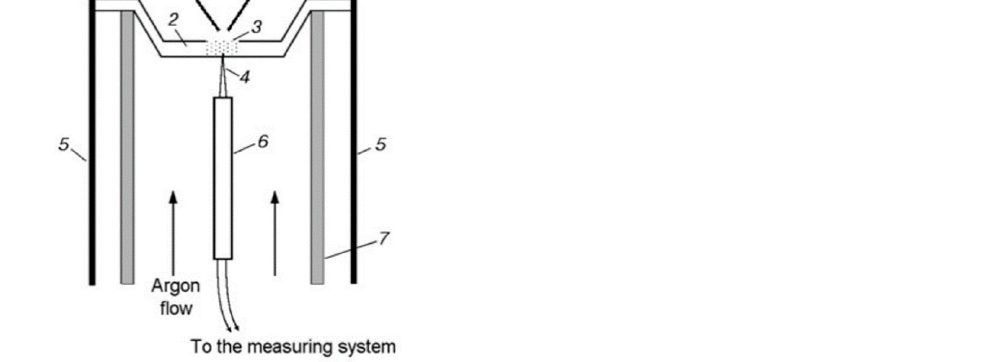
Figure 4 . Configuration of the flow reactor: (1) probe; (2) metal cell; (3) UHMWPE (or PE) + TPP powder; (4) thermocouple; (5) electric leads; (6) ceramic tube; (7) quartz tube.